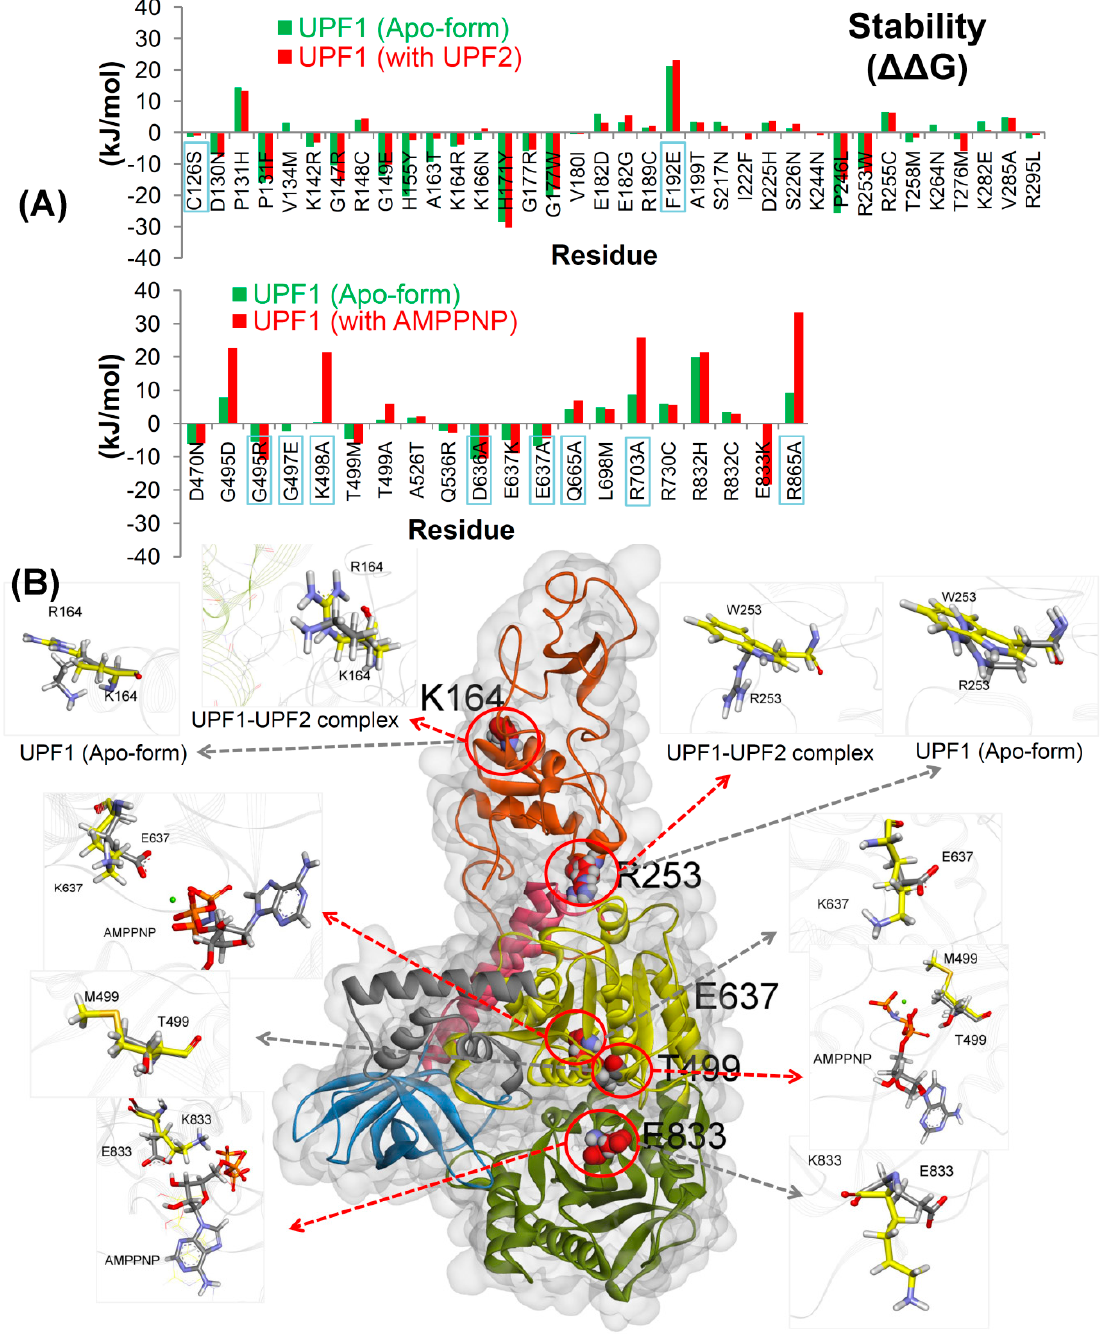
Figure 2. E ff ects of mutations on the UPF1 protein. ( A ) UPF1 structural stability change ( ∆∆ G; kJ / mol) upon mutation. In addition, the mutations from previous studies [4,7,11,13,19,21,32,33] are indicated by labels with the blue box. ( B ) The UPF1 structure showing mutations studied by MDS. The red arrows represent UPF1 mutations in the complex with UPF2 / AMPPNP and the grey arrows show mutations in the apo-form of UPF1. C α atoms of the wild-type and mutated residues are shown in grey and yellow, respectively (di ff erent domains of UPF1 are colored as per Figure 1). Color scheme: oxygen in red, hydrogen in silver, nitrogen in blue, and sulfur in orange.